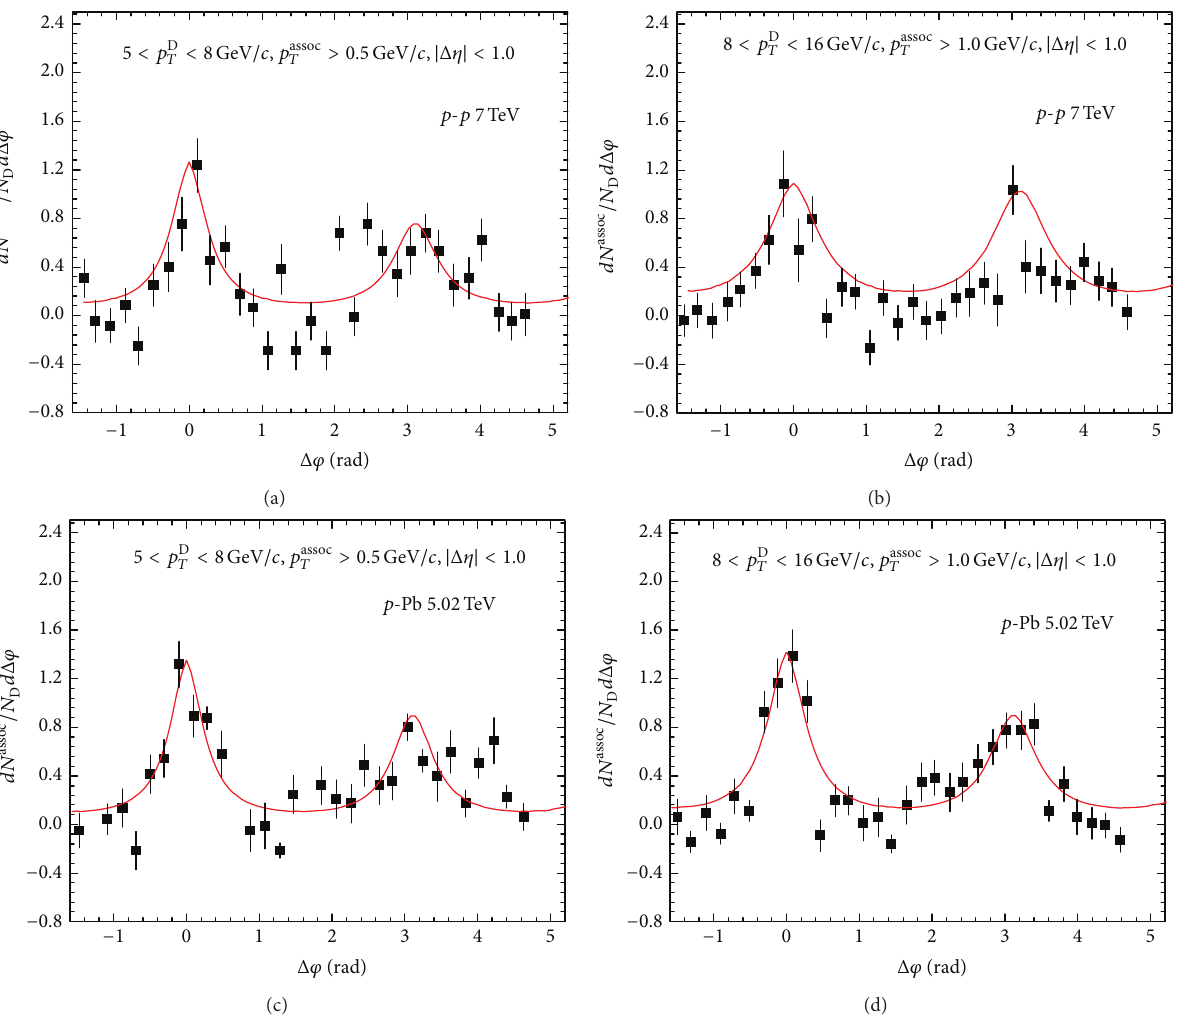
= 7 TeV NN > 0 . 5 GeV/ c (a, 𝑇